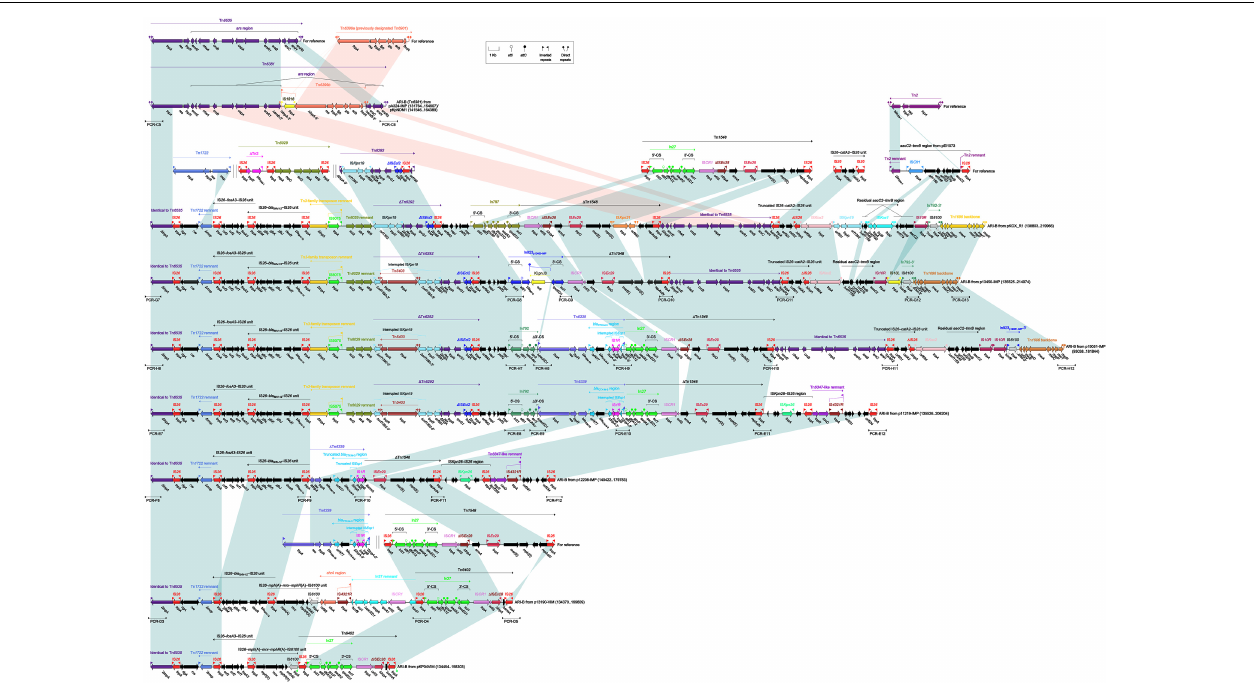
FIGURE 4 | Organization of ARI-B islands and comparison to related regions. Genes are denoted by arrows. Genes, mobile elements and other features are colored based on their functional classification. Shading denotes regions of homology (nucleotide identity > 95%). Numbers in brackets indicate nucleotide positions within corresponding plasmids. The accession numbers of Tn 6535 (Tan et al., 2014), Tn 6399a (Murata et al., 2002), Tn 1722 (Allmeier et al., 1992), Tn 6029 (Cain et al., 2010), Tn 6292 (Wei et al., 2016), Tn 1548 (Galimand et al., 2005), IS 26 – catA2 –IS 26 unit (Xiang et al., 2015), Tn 2 (Bailey et al., 2011), aacC2 – tmrB region (Partridge